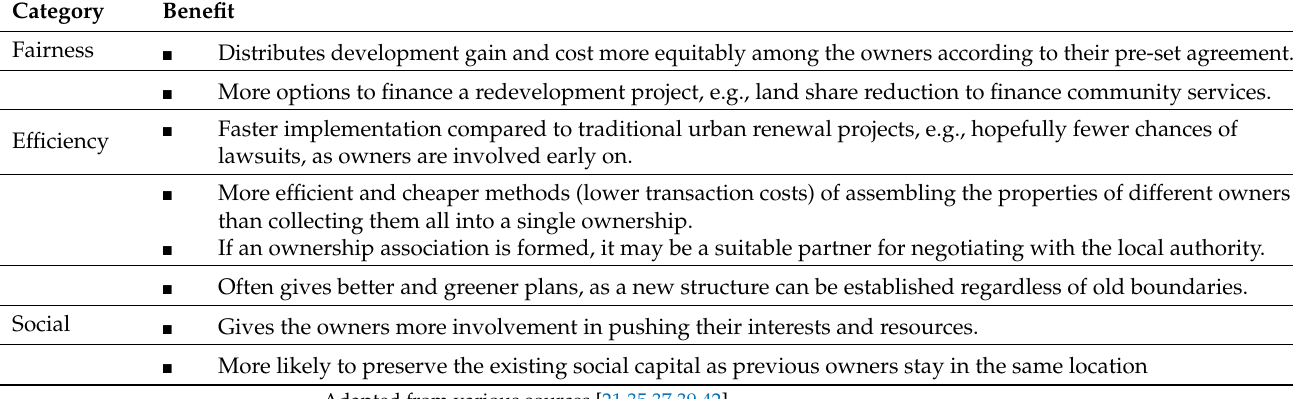
Table 1. Some potential benefits of LR application in urban renewal.